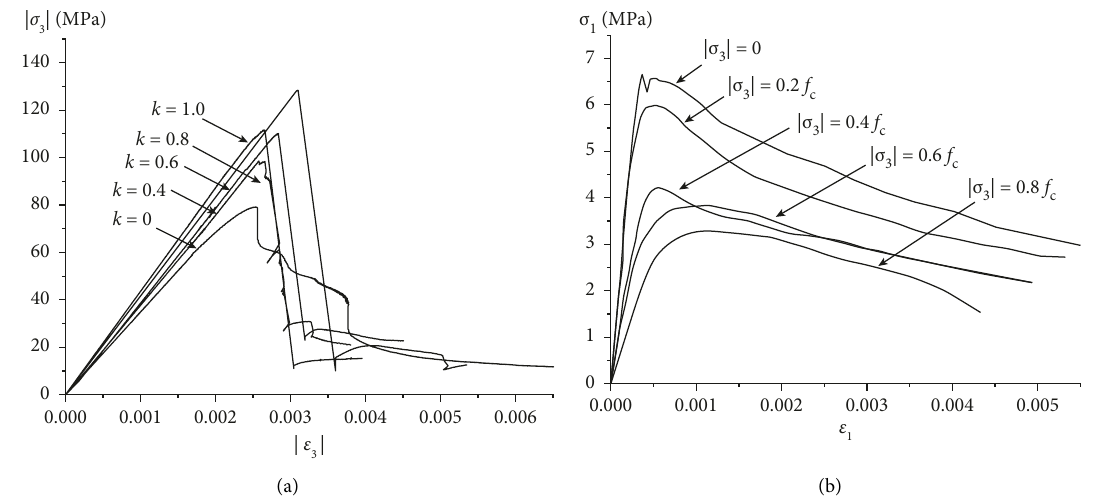
Figure 4: Stress-strain curves of RPC specimens under (a) C-C and (b)